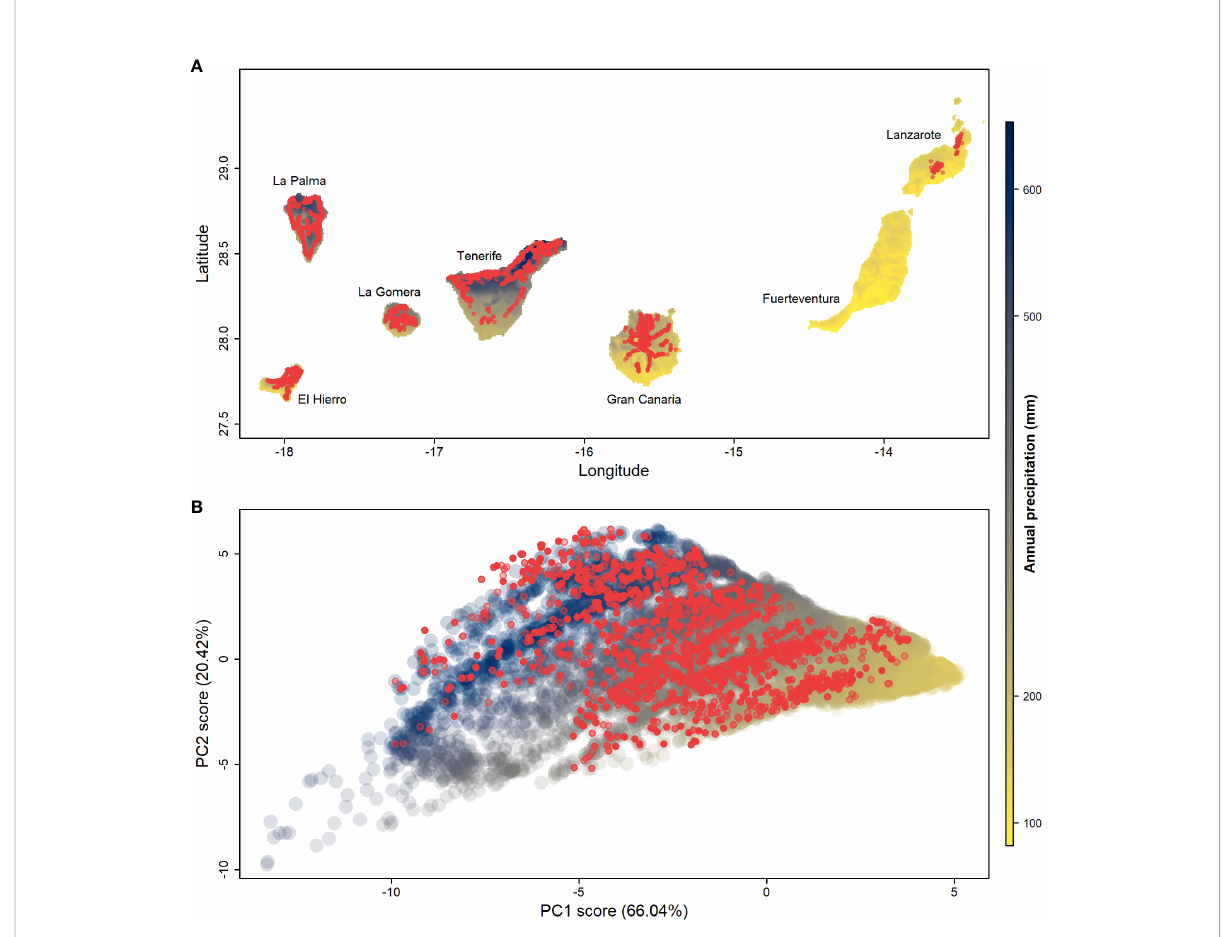
FIGURE 2 Climate space on the Canary Islands and climatic occupation of Aeonium on the Canary Islands. (A) Map of the Canary Islands colored according to the annual precipitation gradient; red dots represent Aeonium sampling sites used to calculate the climatic occupation on the islands; (B) Principal components analysis (PCA) of the climatic range throughout the Canary Islands. Dots colored by the annual precipitation gradient are random points extracted from the map (A) to represent the overall climatic space; red dots represent the Aeonium spatial sampling sites extracted from (A) . PCA loadings can be found in Supplementary Table